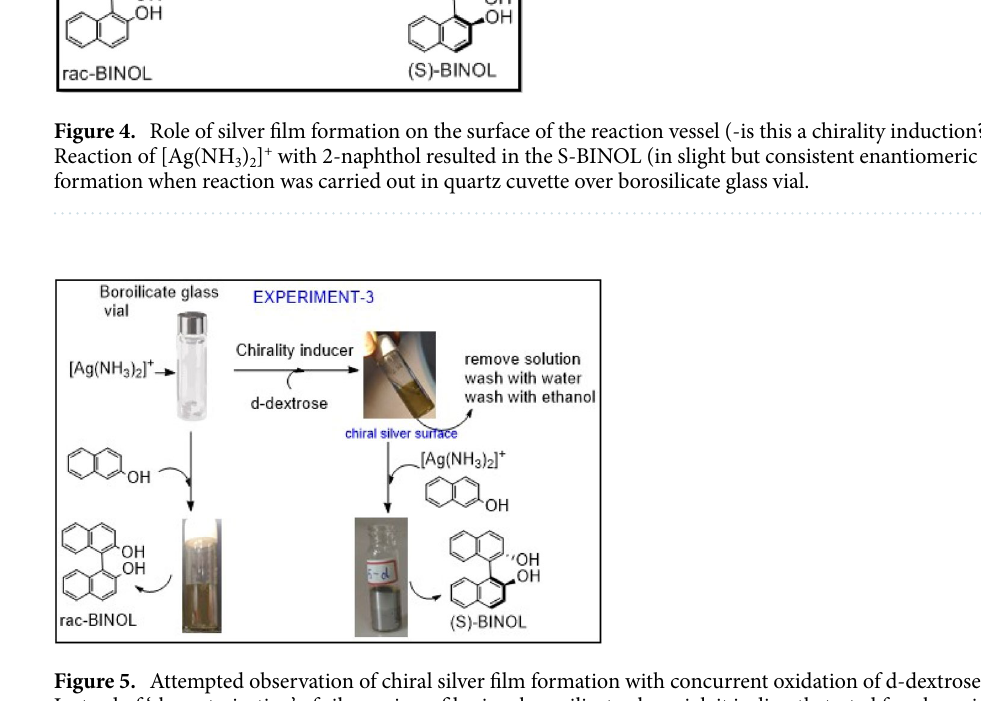
Figure 5. Attempted observation of chiral silver film formation with concurrent oxidation of d-dextrose. Instead of ‘characterization’ of silver mirror film in a borosilicate glass vial, it is directly tested for observing enantioselective BINOL formation. Although, observed selectivity is very weak but consistency in results and proposed mechanism provoke in depth